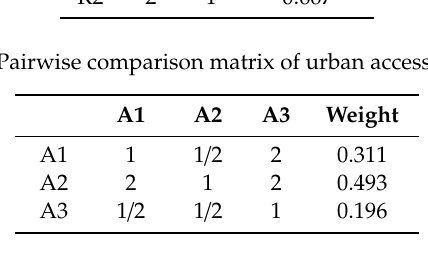
Table A4. Pairwise comparison matrix of urban capacity indicators.